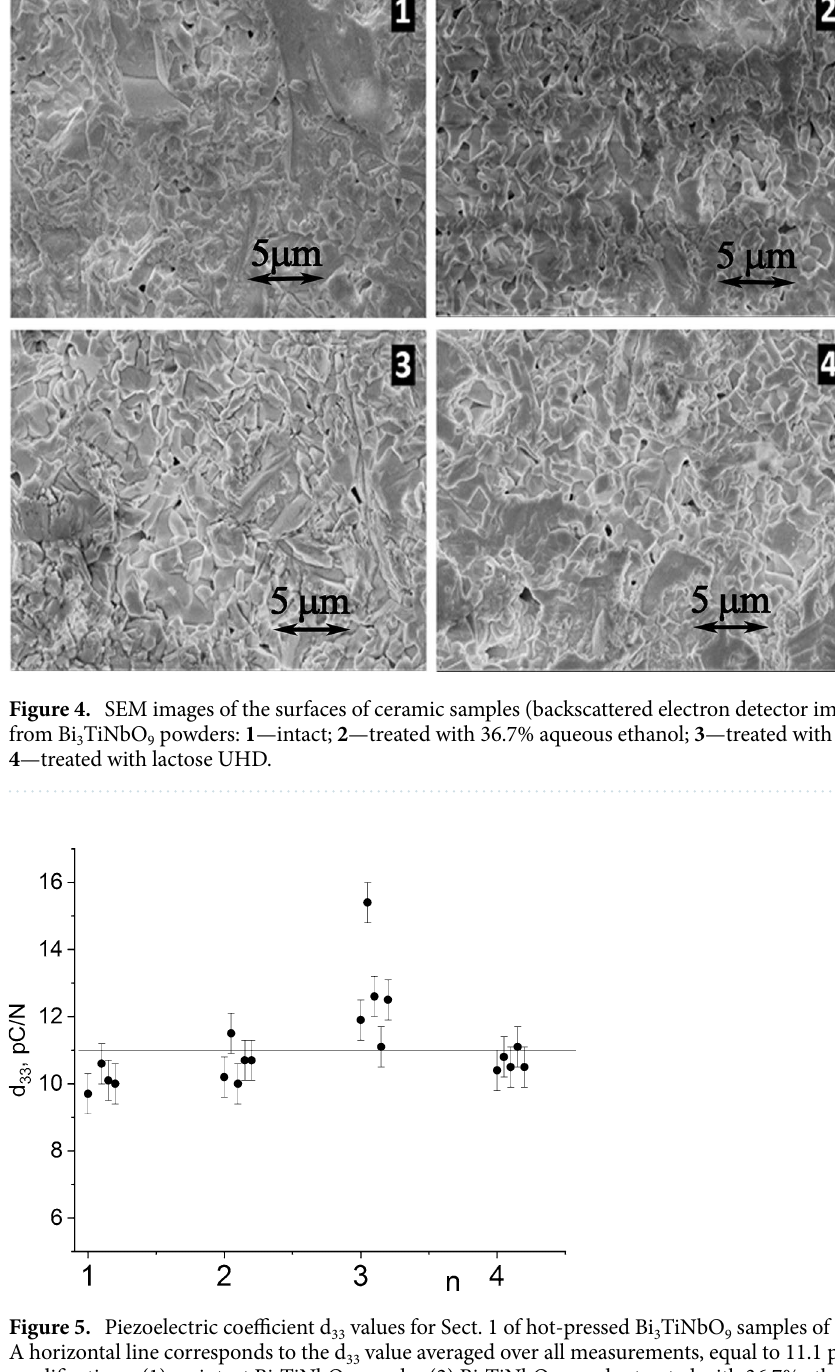
Measurements of dielectric permittivity and dielectric loss tangent. The obtained data are shown in Figs. 6, 7 and 8. Clear maxima are observed for dependencies ε(T) at T c = 1180 К (Figs. 6, 7), apparently caused by the ferroelectric phase transition occurring in the BLSF phase contained by the specimens, with the tempera- ture at the maximum corresponding to the Curie temperature (T c ) of the phase. No shifts are observed in the position of the ε maximum at T c with changes in the frequency of the measuring field. This maximum degenerates into a point of inflection under the effect of conductivity at lower frequencies.